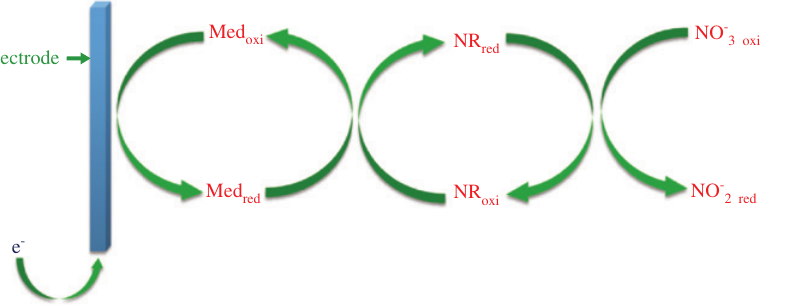
Scheme 2: Schematic representation of flow of electrons in nitrate biosensor. Redox mediators (Med) are often employed to improve electron flow between electrode and the deep-seated reaction centers of nitrate reductase